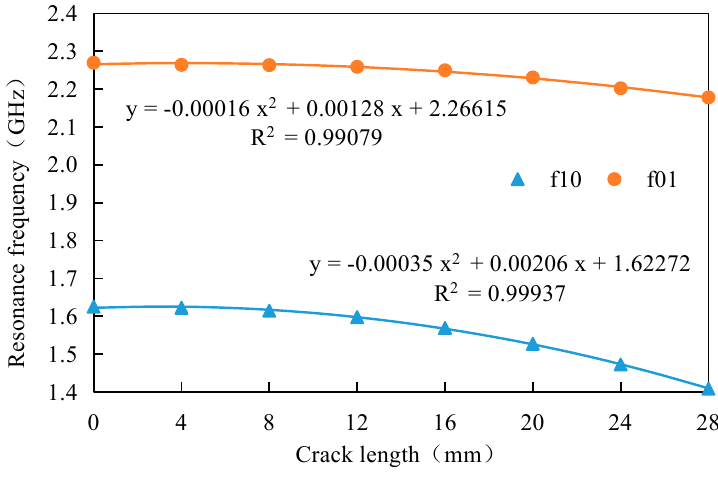
Figure 8. The relation between resonant frequency and crack length of oblique crack